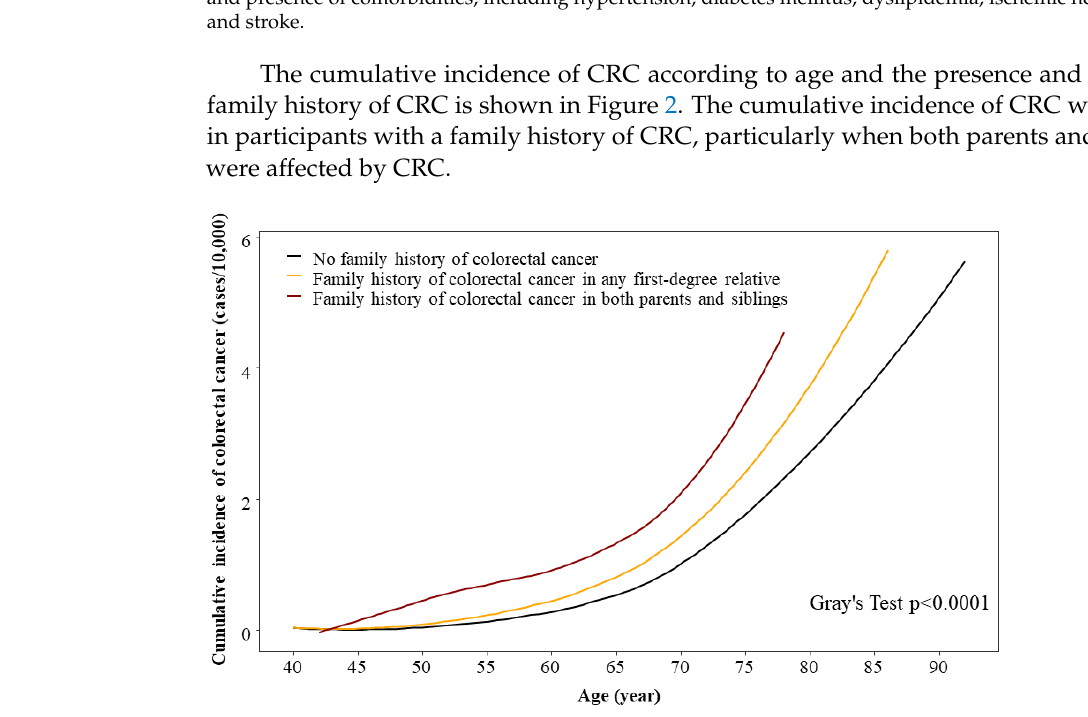
Figure 2. Cumulative incidence of colorectal cancer (CRC) according to a family history of CRC.